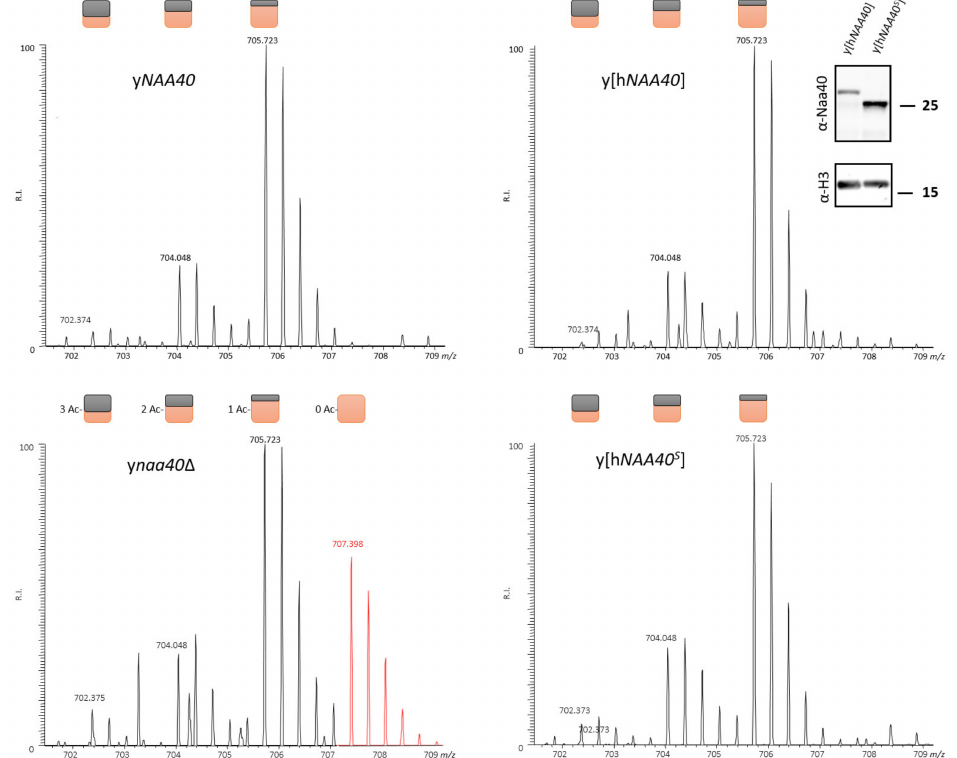
Figure 4. Ectopic expression of hNaa40 L and hNaa40 S in y naa40 ∆ yeast rescues N -acetylation of the newly identified in vivo yNaa40p substrate H2A.Z. Besides the identification of various N -acetylated forms of the mature N-terminus of yH2A.Z ( 2 SGKAHGGKGKSGAKDSGSLR 21 ), the fully N -free form (red MS trace, ‘0 Ac’ peak indicative of ‘no in vivo N -acetylation) was only demonstrated in the y naa40 ∆ setup as inferred from the triply charged variant observed at the higher m /z 707.398. The 5 Da spacing between the distinct isotopic envelopes, corresponds with the gain/loss of an in vivo N -acetyl group (i.e., free amines were in vitro N -acetylated using 13 C 2 D 3 -NHS acetate; introducing a 5 Da heavier acetyl moiety to each free amine) [29,30]. Colored squares indicate the number of in vivo (black) and in vitro (orange) acetyl moieties present per detected isotopic envelope. Although y naa40 deletion reduces the overall degree of H2A.Z N -acetylation (bottom left panel), ectopic expression of hNaa40 L as well as hNaa40 S restores the degree of N -acetylation of the H2A.Z N-terminus to wild type levels. The inset in the upper right panel confirmed the specific expression of hNaa40p proteoforms hNaa40 L and hNaa40 S in the y[h NAA40 ] and y[h NAA40 S ] strain, respectively. Histone H3 was probed as a loading